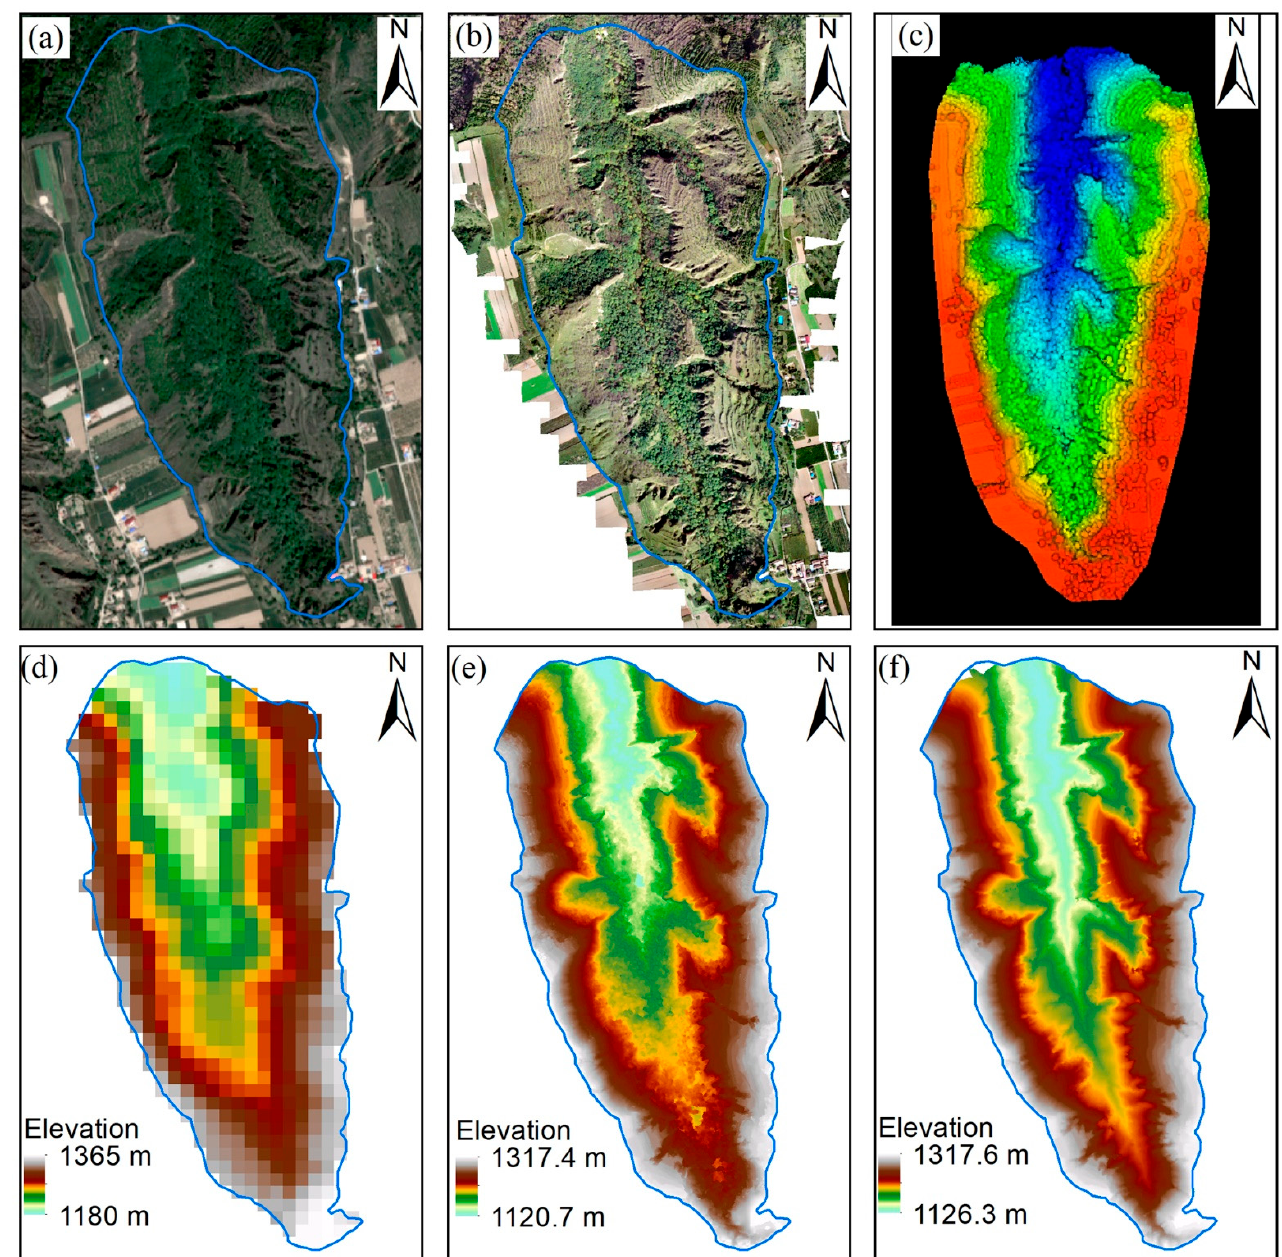
Figure 3. Comparisons of DEMs from different data sources for the Yangjiagou forest catchment: ( a ) QuickBird multispectral image, ( b ) Orthophoto merged from DAP images, ( c ) ALS point cloud, ( d ) 30 m × 30 m ASTER GDEM (public dem), ( e ) 0.5 m × 0.5 m DSM reconstructed from DAP images, and ( f ) 0.5 m × 0.5 m DEM from ALS point cloud. DEM, digital elevation model; DAP, digital aerial photogrammetry; ALS, aerial laser scanning; DSM, digital surface model.